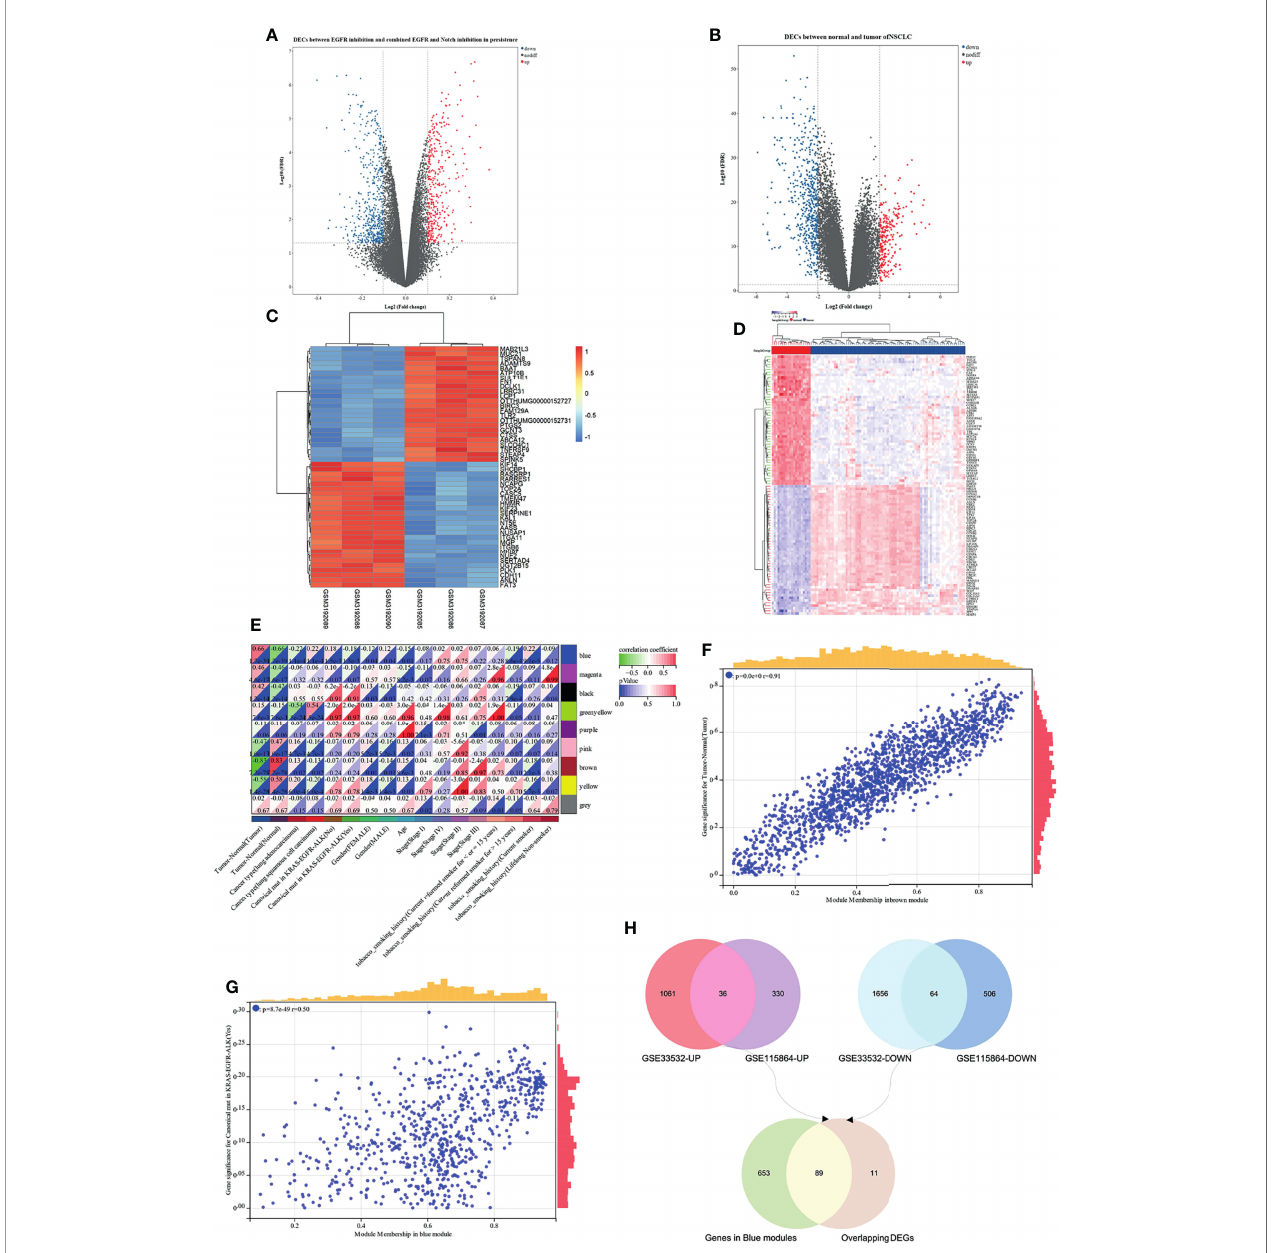
FIGURE 5 | WGCNA and differentially expressed genes (DEGs) of EGFR-TKI drug persistence in EGFR mutant NSCLC. (A) Volcano maps of DEGs between two groups: EGFR inhibition and combined EGFR and Notch inhibition in EGFR mutant of NSCLC. (B) Volcano maps of DEGs between normal and tumor. Upregulated genes are shown in red and downregulated genes are shown in green dots. (C, D) Heatmap showing the expression level of the top 50 DEGs. (E) Each column represents a clinical feature and each row represents a module eigengene; red represents a positive correlation and green represents a negative correlation; the darker the hue, the higher the correlation. (F, G) Scatter plot of eigengene modules. (H) Venn diagram showed the intersection of overlapping DEGs of N-T DEGs and E-N DEGs and genes in blue